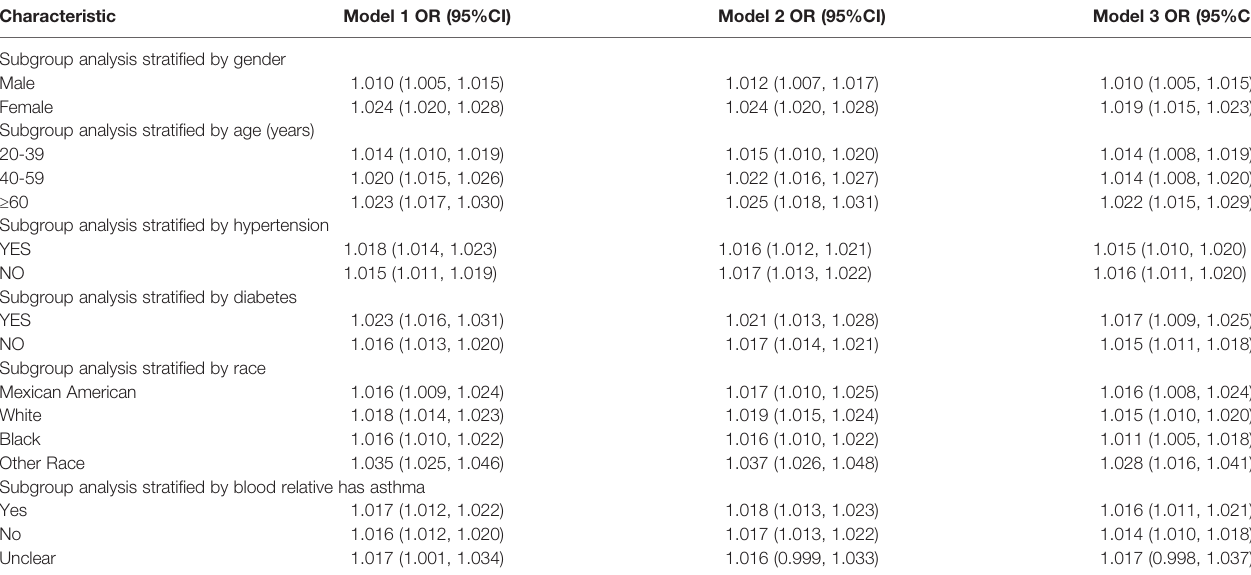
TABLE 4 | Subgroup analysis between METS-IR index with asthma prevalence.